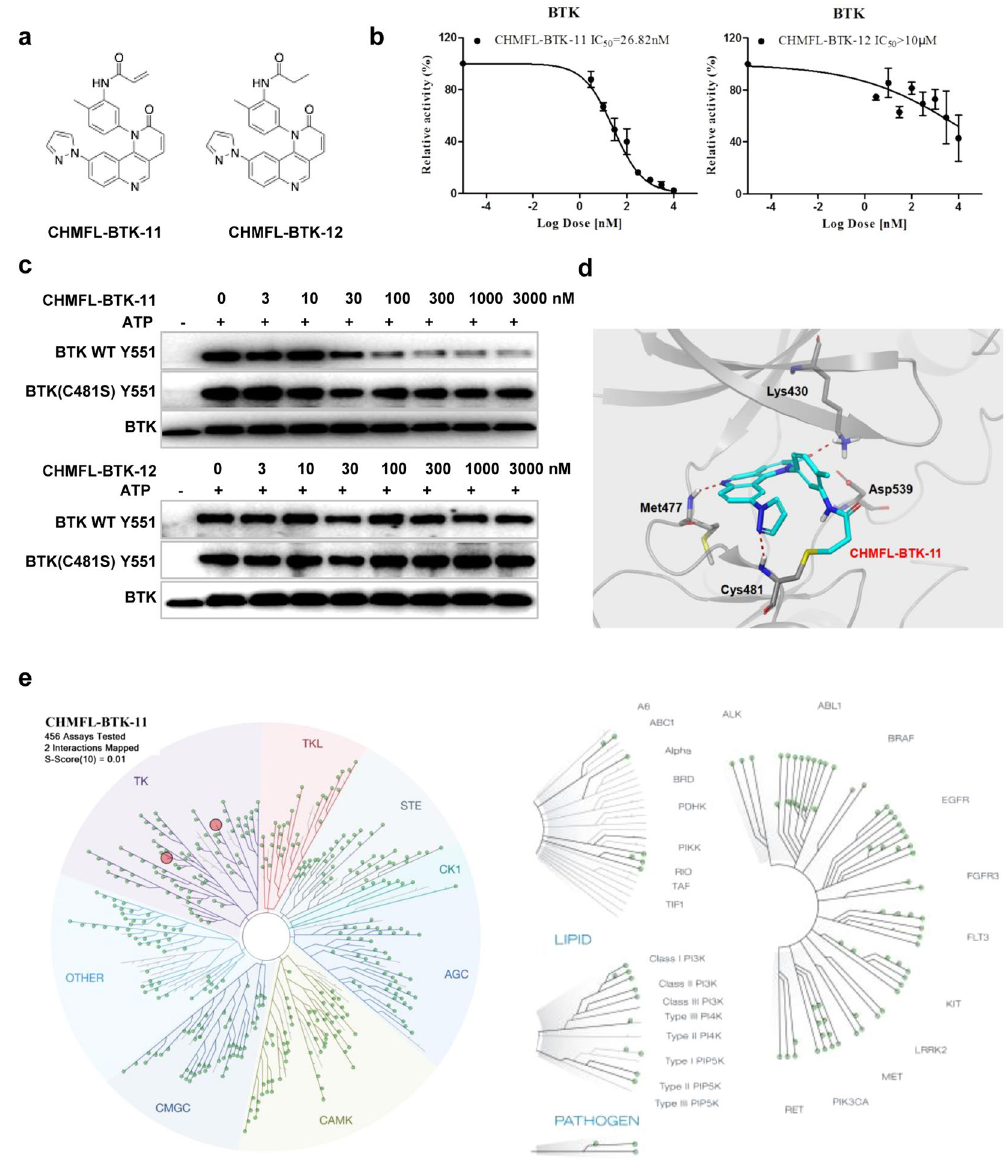
Figure 1. Characterization of CHMFL-BTK-11 as an selective irreversible Bruton’s tyrosine kinase (BTK) inhibitor. ( a ) Chemical structure of CHMFL-BTK-11 and CHMFL-BTK-12; ( b ) ADP-Glo biochemical characterization of CHMFL-BTK-11 and CHMFL-BTK-12 against BTK kinase. ( c ) In vitro kinase assay using Flag-tagged BTK of wild-type or C481S immunopurified from HEK293 cells showed that CHMFL-BTK-11 inhibits only wild-type BTK, whereas CHMFL-BTK-12 fails to inhibit both wild-type and C481S BTK. Blots were cropped for improved clarity and conciseness. ( d ) Predicted mode of binding of CHMFL-BTK-11 to BTK based upon molecular modeling (PDB: 3OCS); ( e ) TreeSpot view of the kinase selectivity profile of CHMFL-BTK-11 using data generated from the KinomeScan approach. Data were representative of at least 2 independent